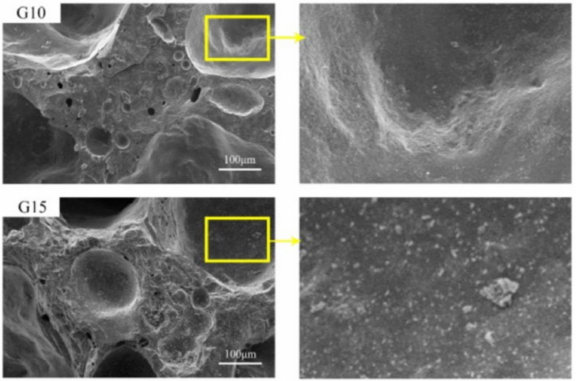
Figure 3. SEM of sintered lightweight aggregate samples with 10% and 15% of water glass content at 1180 ◦ C [30].